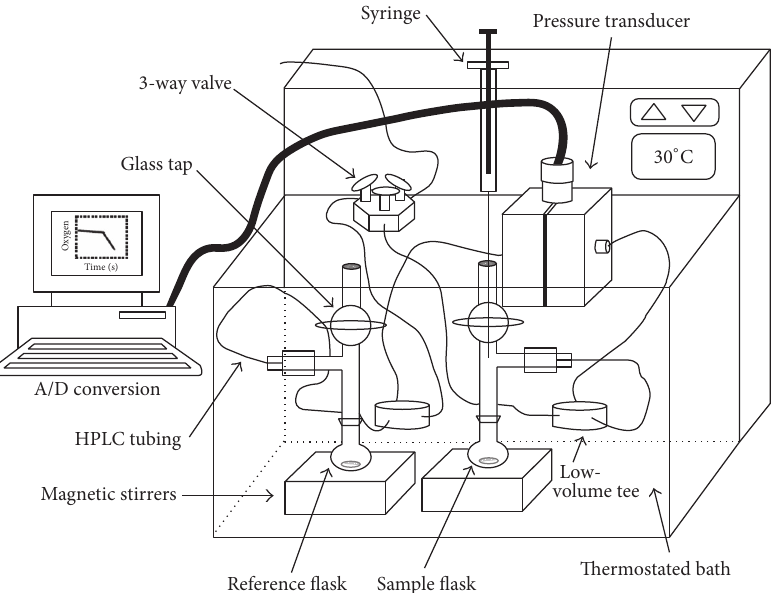
Figure 2: Differential oxygen uptake apparatus for autoxidation kinetics. Reprinted with permission from reference [32].